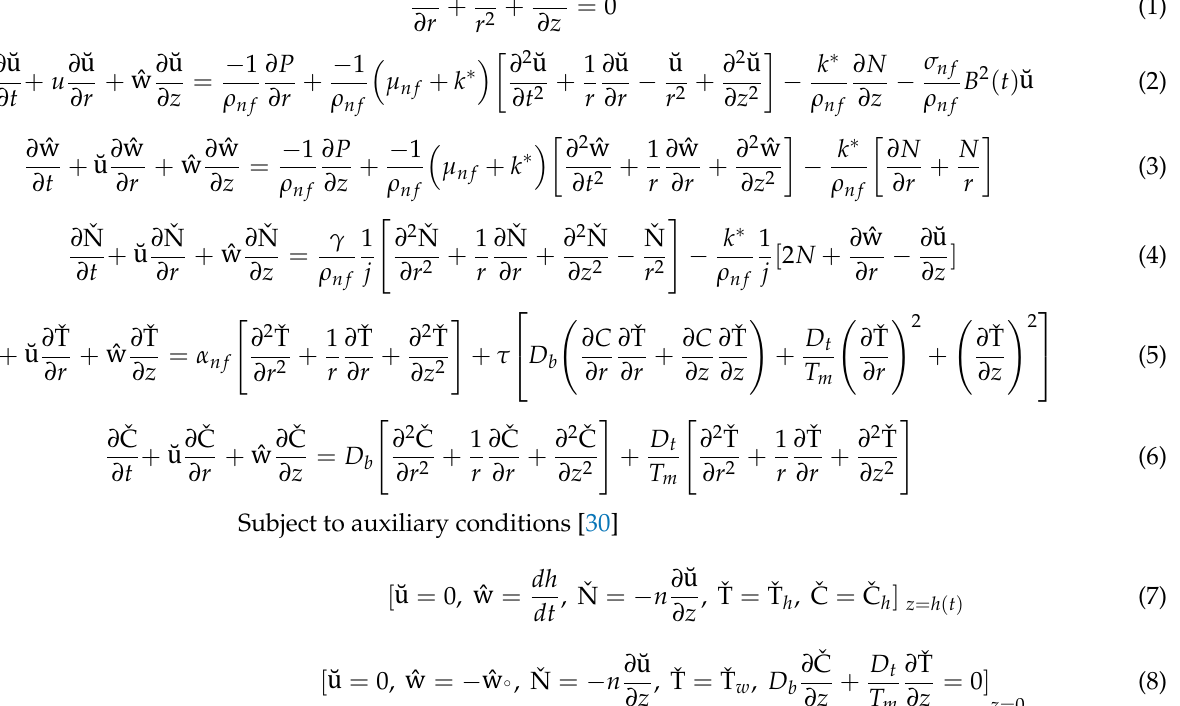
Figure 1. Geometry of the problem .